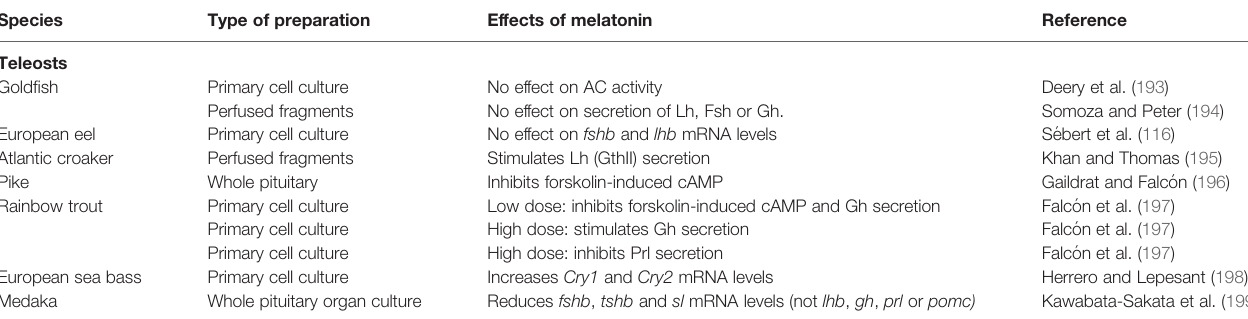
TABLE 4 | Summary of the known effects of melatonin on pituitary in vitro and ex vivo cultures in teleosts.